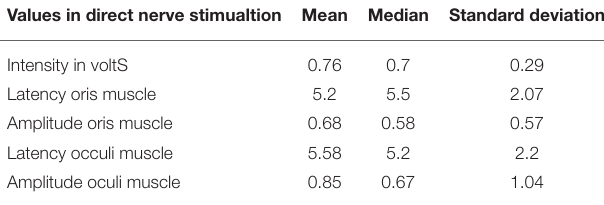
TABLE 2 | Values in direct facial nerve stimulation. Values in direct nerve stimualtion Mean Median Standard deviation Intensity in voltS 0.76 0.7 0.29 Latency oris muscle 5.2 5.5 2.07 Amplitude oris muscle 0.68 0.58 0.57 Latency occuli muscle 5.58 5.2 2.2 Amplitude oculi muscle 0.85 0.67